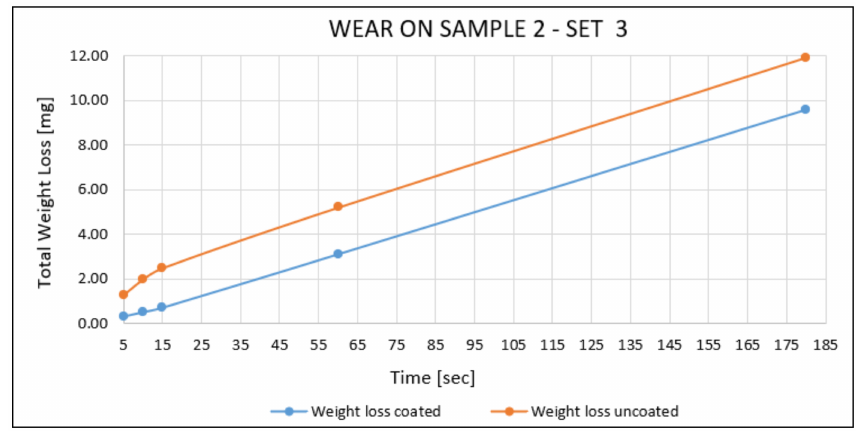
Figure 15. Wear results on the flat sample 2.